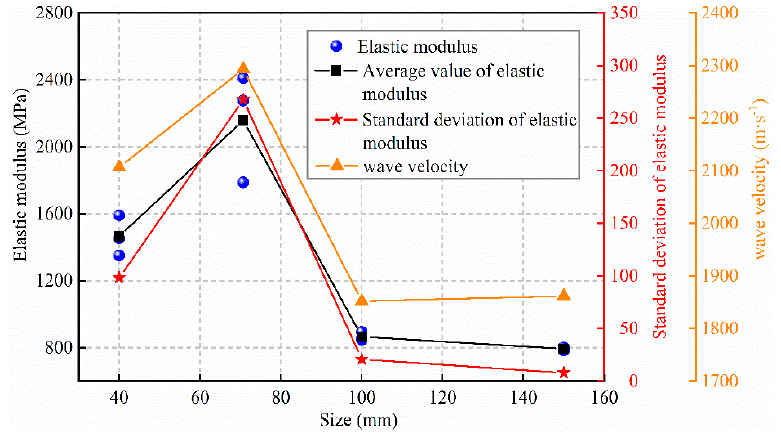
Figure 5. Elastic modulus and wave velocity variation curve of backfills with different sizes.